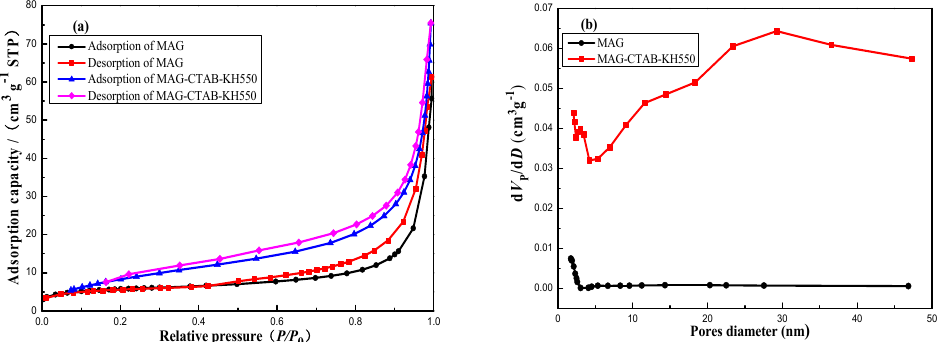
Figure 4. N 2 adsorption/desorption ( a ) curve and pore size distribution and ( b ) of MAG and MAG– CTAB–KH550 (at 10 s of equilibration interval, and − 196 °C of analysis bath